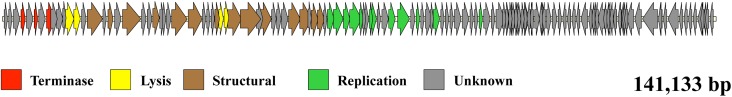
Phage 156 genome map. Diagram of the E. faecalis 156 phage genome. Each arrow represents an orf detected in the genome. The color code indicates the putative function assigned to each detected gene. The genome size (bp) is indicated.